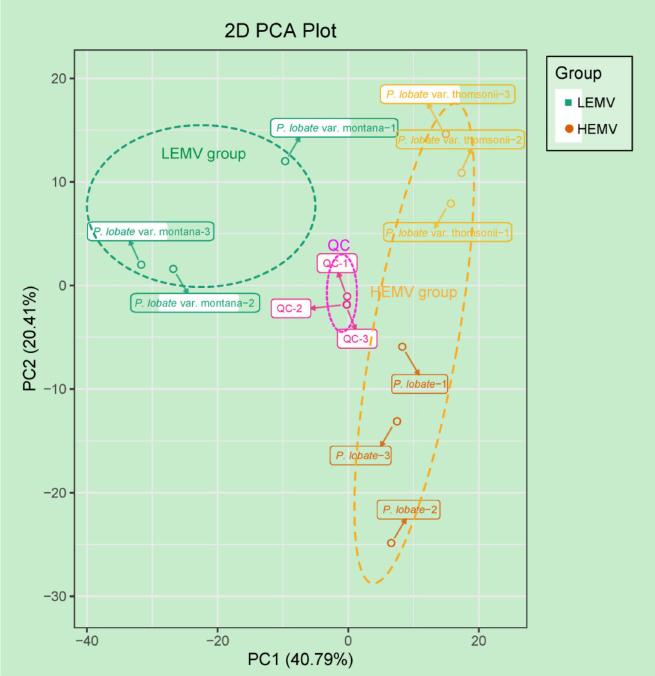
Figure 2. Differential root tuber metabolites among P. lobata , P. lobata var. thomsonii, and P. lobata var. montana. PCA of metabolites identified from P. lobata , P. lobata var. thomsonii, and P. lobata var. montana. Equal volumes of P. lobata , P. lobata var. thomsonii, and P. lobata var. montana root tuber samples were mixed for use as a quality control